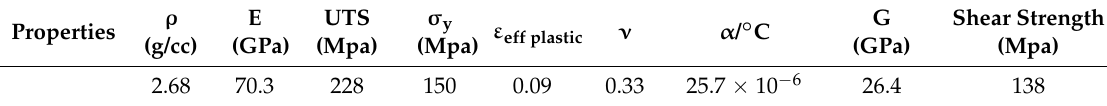
Table 2. Mechanical properties of aluminum 5052-H32.